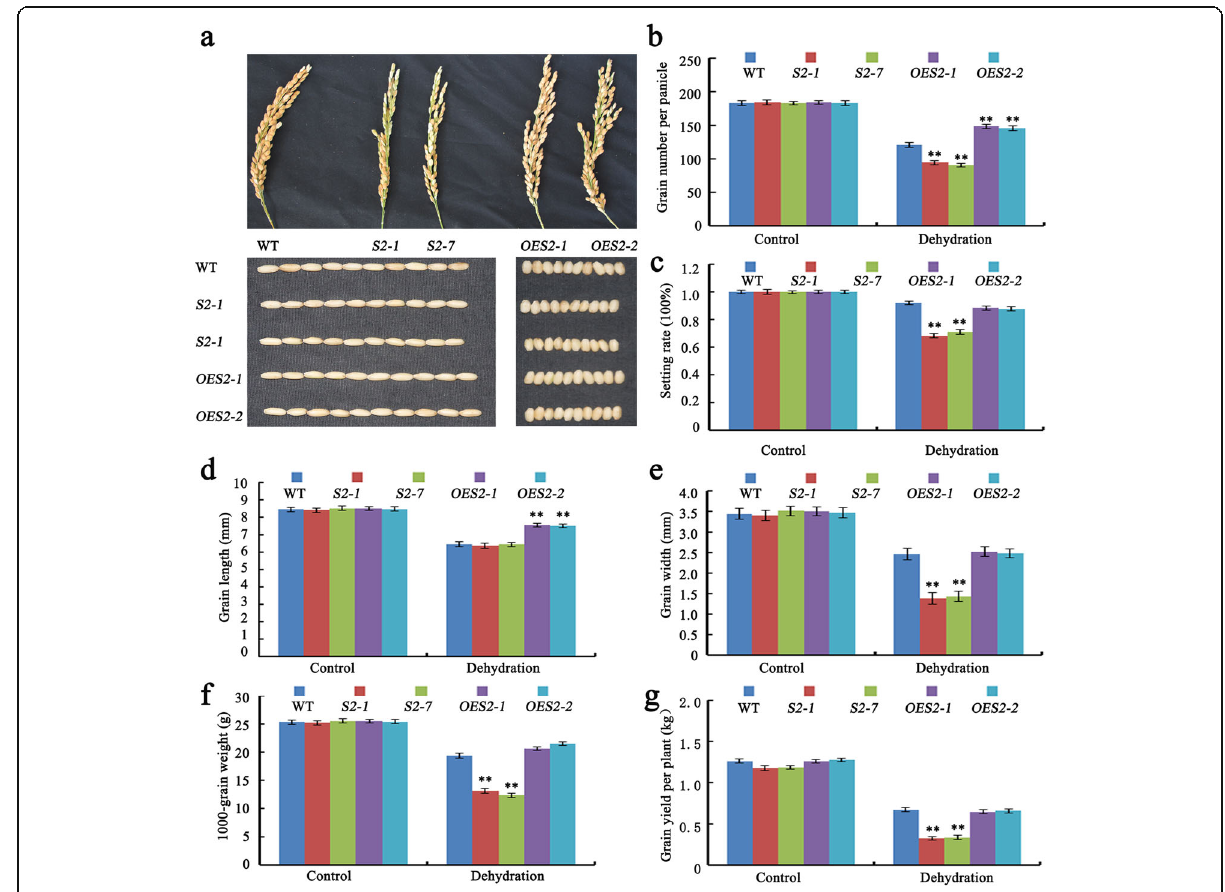
Fig. 2 SAPK2 has large effects on grain size and weight under RDS for 30 days. a Panicle and grain phenotypes of WT, sapk2 mutant lines and OE lines under RDS. b-f Comparison of agronomic traits including grain number per panicle (b) , setting rate ( c ), grain length ( d ), grain width ( e ), 1000-grain weight ( f ), grain yield per plant ( g ) among WT, sapk2 mutant lines and OE lines under RDS. Data in ( b-f ) are shown as means ± SD ( n = 20) from three replicates. A student ’ s t -test was used to generate P values; “ ** ” indicate significance at P <